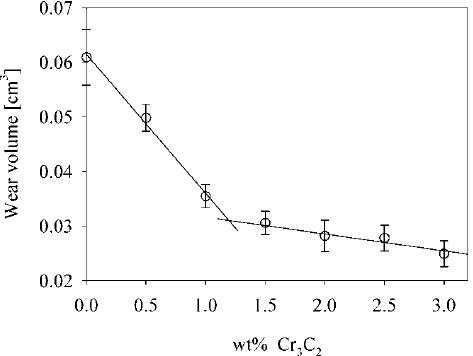
Figure 7. Volume loss of the WC-10Co cemented carbides vs. the Cr3C2 content. The two regression lines fitted to the data at low ( ≤ 1 wt%) and high ( ≥ 1.5 wt%) Cr3C2 content are reported.